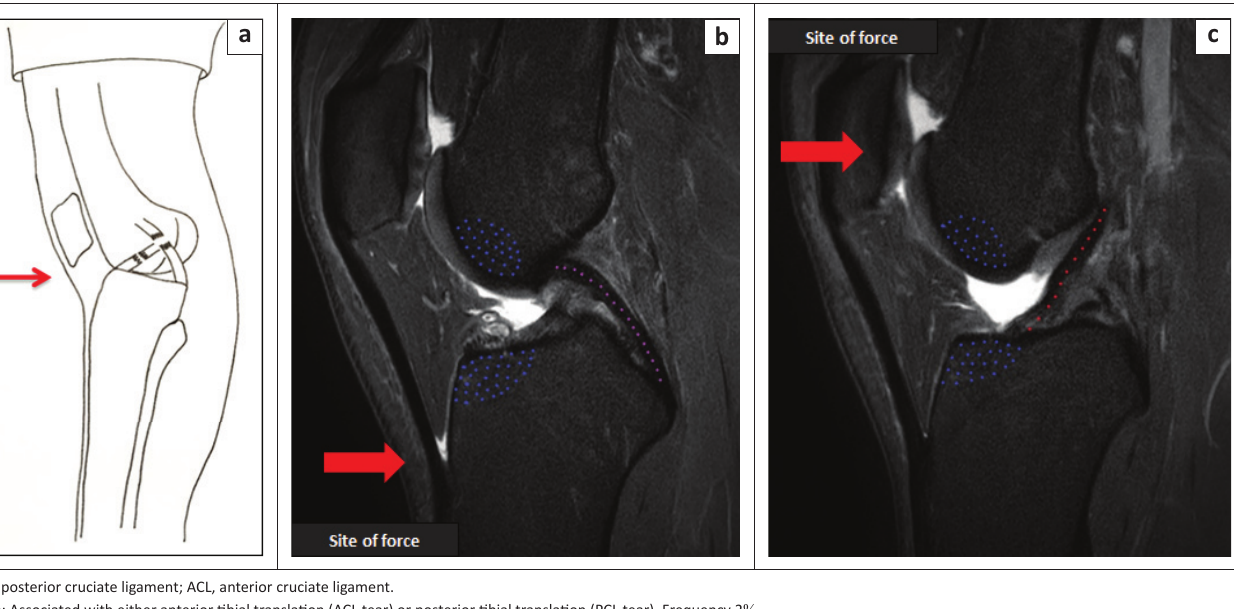
FIGURE 1: Pure hyperextension: (a) Schematic depicts site of force at anterior knee, (b) and (c) depict anterior central tibia, and anterior femoral condyle impaction bone bruises with posterior cruciate ligament (b) and anterior cruciate ligament (c) tear. Posterior capsule may also be injured.